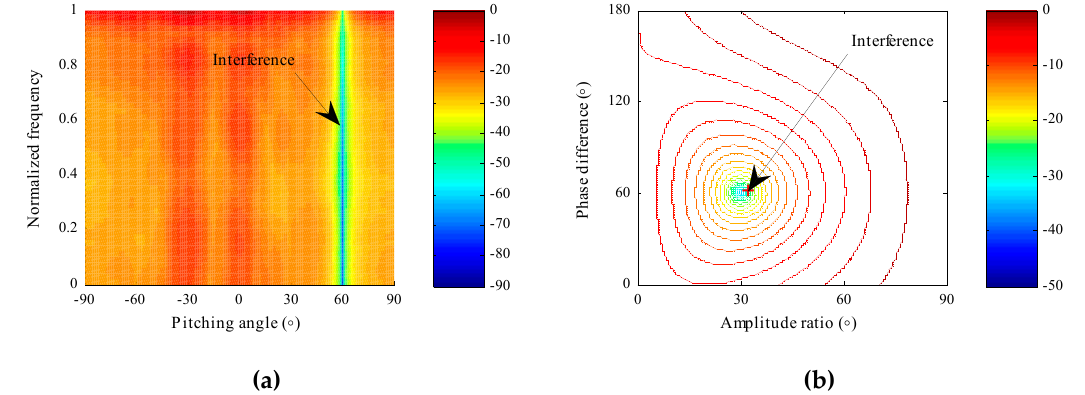
Figure 4. Array patterns when parameters are fixed as that of the interference using the proposed STPAP beamforming algorithm. ( a ) Null forms in the space domain and time domain towards the interference. ( b ) Null forms in the polarization domain towards the interference.